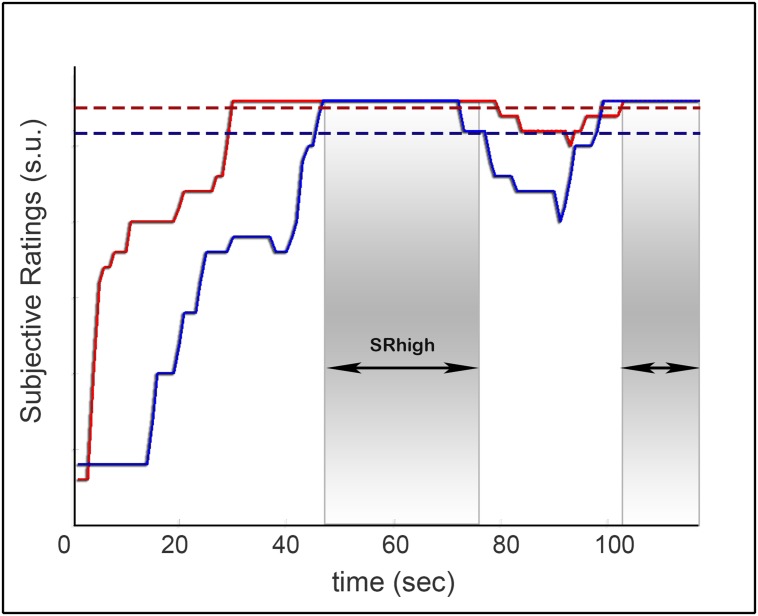
Identifying subjective togetherness. SR for one game round provided by two players (red and blue lines). The thresholds for high togetherness (top 30% across all game rounds) are marked by red and blue dotted lines. Game periods, in which both players provided above threshold responses, were indexed as high togetherness (SRhigh, gray regions).